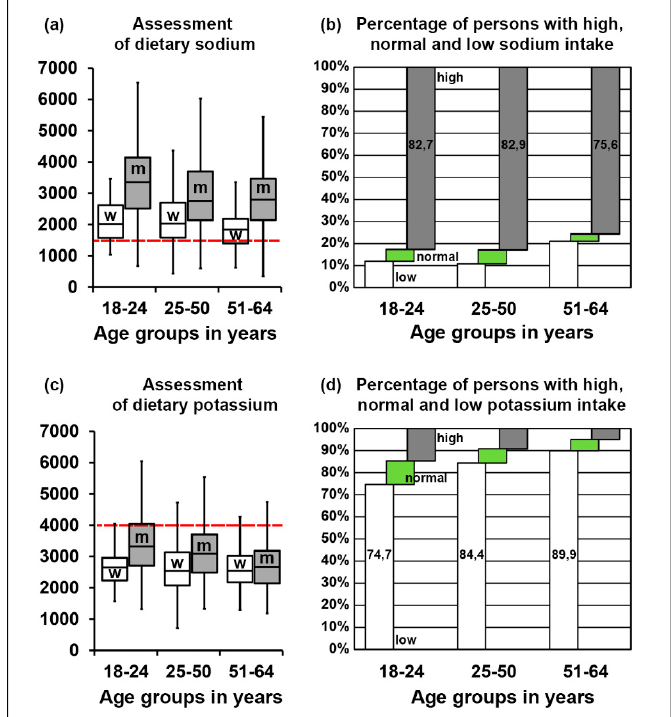
Figure 3. ( a ) Median intake levels of sodium in different gender and age groups in mg/day. ( b ) Percentage of persons with a discrepancy between reported sodium intake and the reference values in different age groups. ( c ) Median intake levels of potassium in different gender and age groups in mg/day. Red dashed lines depict the recommended intake level for sodium ( a ) and potassium ( b ); w indicates women, m–men. ( d ) Percentage of persons with a discrepancy between reported potassium intake and reference values in different age groups. See also Table S2.